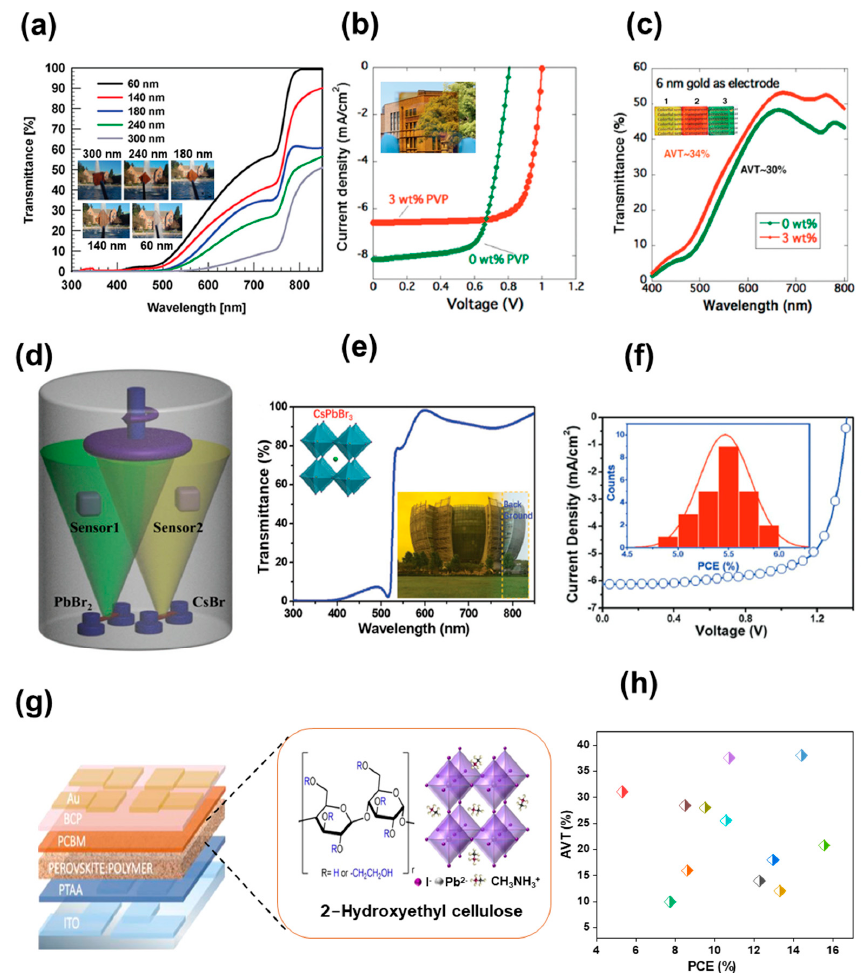
Figure 2. ( a ) UV-Visible spectra with di ff erent perovskite fi lm thicknesses (Inset: Photograph of